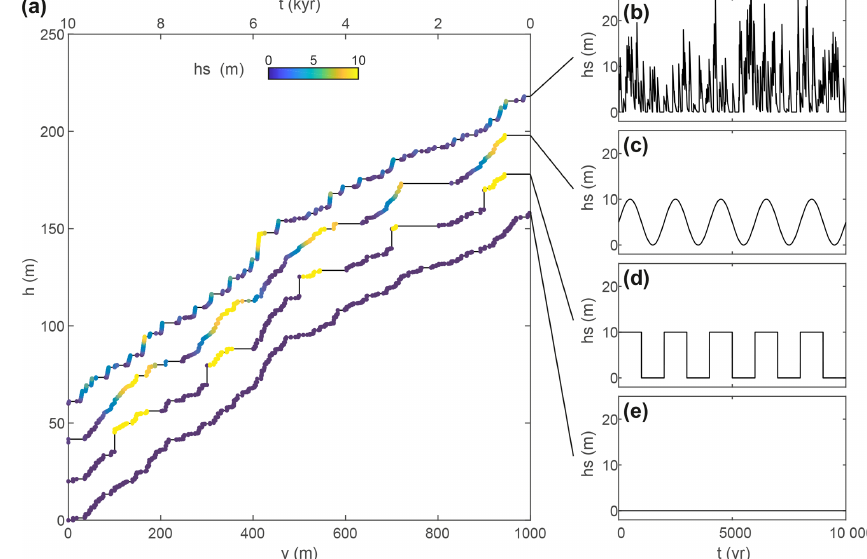
Figure 8. Impact of fault burial by sediment cover on river profile. (a) River profiles are generated with no sediment cover ( h s = 0; see panel e ), with step-like temporal variations for sediment cover with a periodicity of 2000 years (see panel d ), with sinusoidal temporal variations for sediment cover with a periodicity of 2000 years, mimicking climatic changes (see panel c ), with a temporal variation of sediment cover induced by earthquakes (see panel b ). The mean sediment cover thickness, h s , is equal to 5m in panels (b) , (c) and (d) . River profiles are indicated with black lines and the sediment cover thickness at the time of knickpoint formation is indicated by the colour of the points. For readability, the river profiles are shifted by 20m on panel (a)